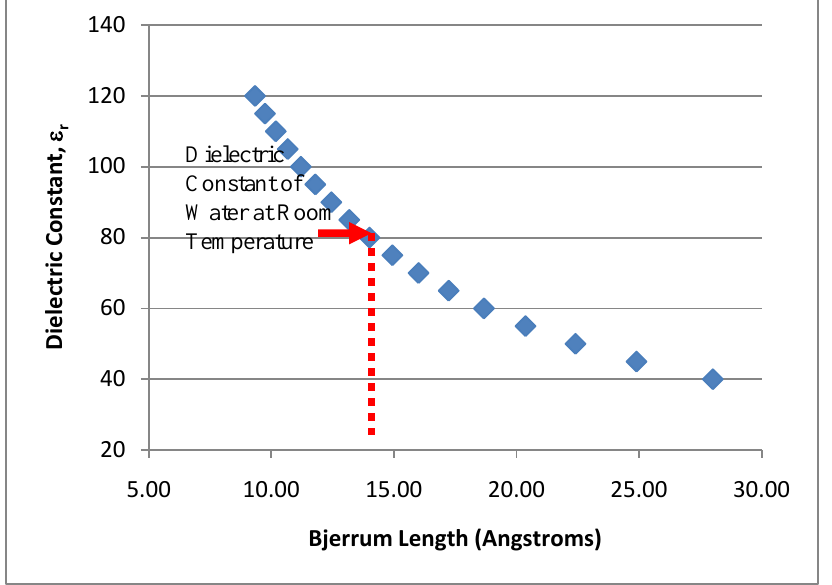
) vs. Dielectric B